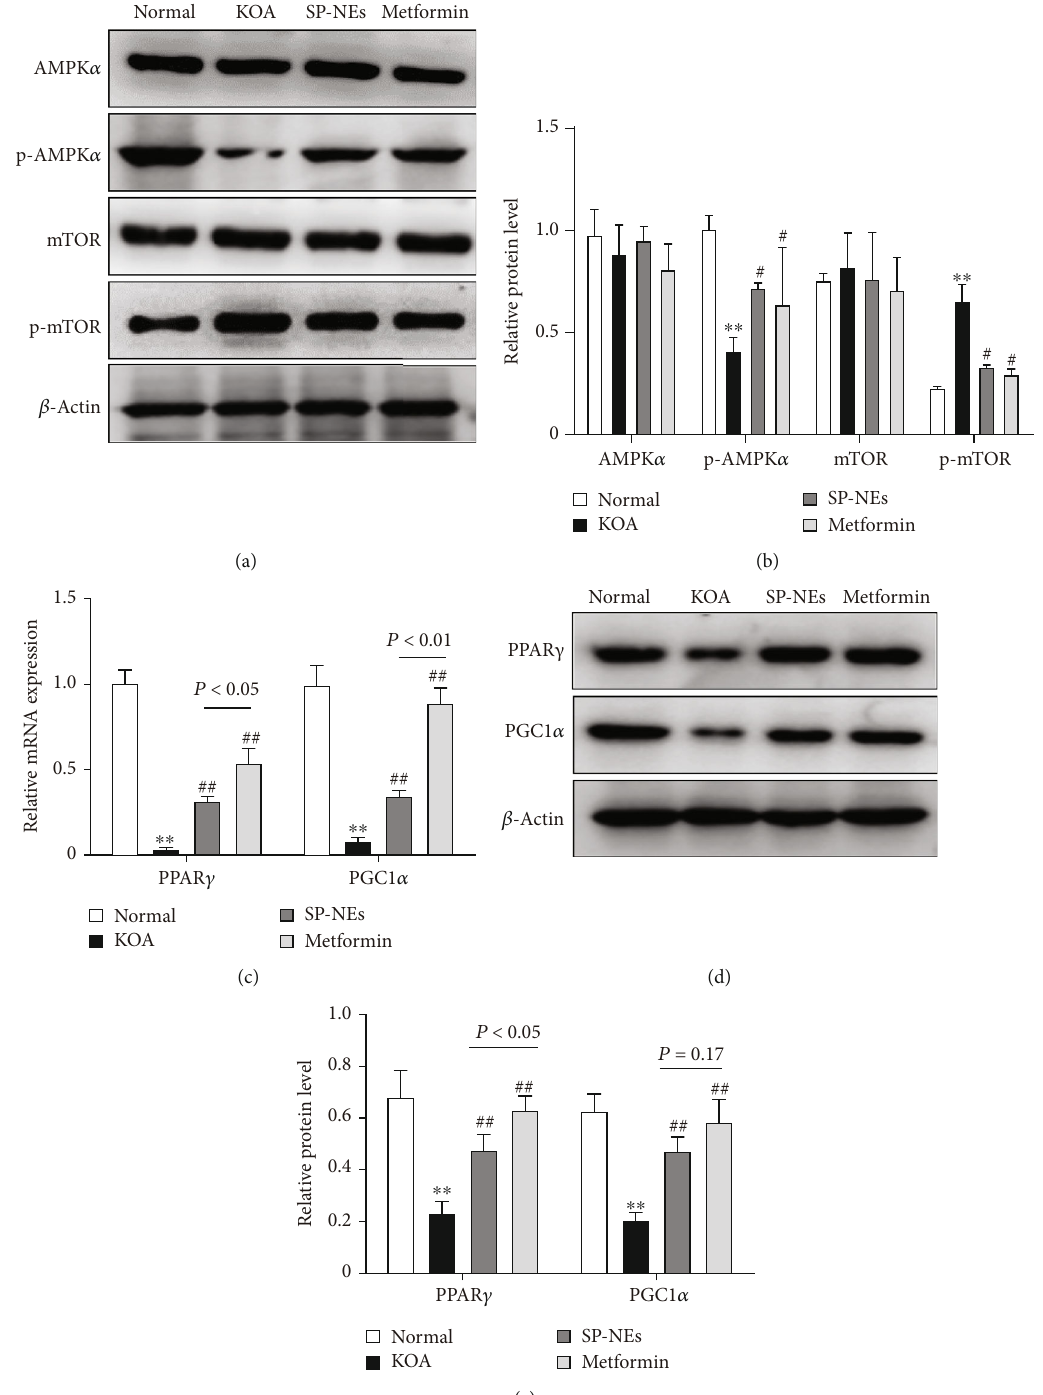
Figure 5: SP-NEs regulate mTOR Signaling via enhanced AMPK activity in vivo. (a) Typical protein bands of AMPK α , p-AMPK α , mTOR, and p-mTOR in synovium for each group. (b) Relative protein level of AMPK α , p-AMPK α , mTOR, and p-mTOR for each group. ∗∗ P < 0 : 01 vs. the normal, ## P < 0 : 01 vs. the KOA. (c) Gene level of PPAR γ and PGC1 α in synovial tissues of rats in each group. ∗∗ P < 0 : 01 vs. the normal, ## P < 0 : 01 vs. the KOA, P < 0 : 05 , P < 0 : 01 , comparison between the underlined two groups. (d) Typical protein bands of PPAR γ and PGC1 α in synovium for each group. (e) Relative protein level of PPAR γ and PGC1 α in synovial tissues of rats in each group. ∗∗ P < 0 : 01 vs. the normal, ## P < 0 : 01 vs. the KOA, P < 0 : 05 , P = 0 : 17 , comparison between the underlined two